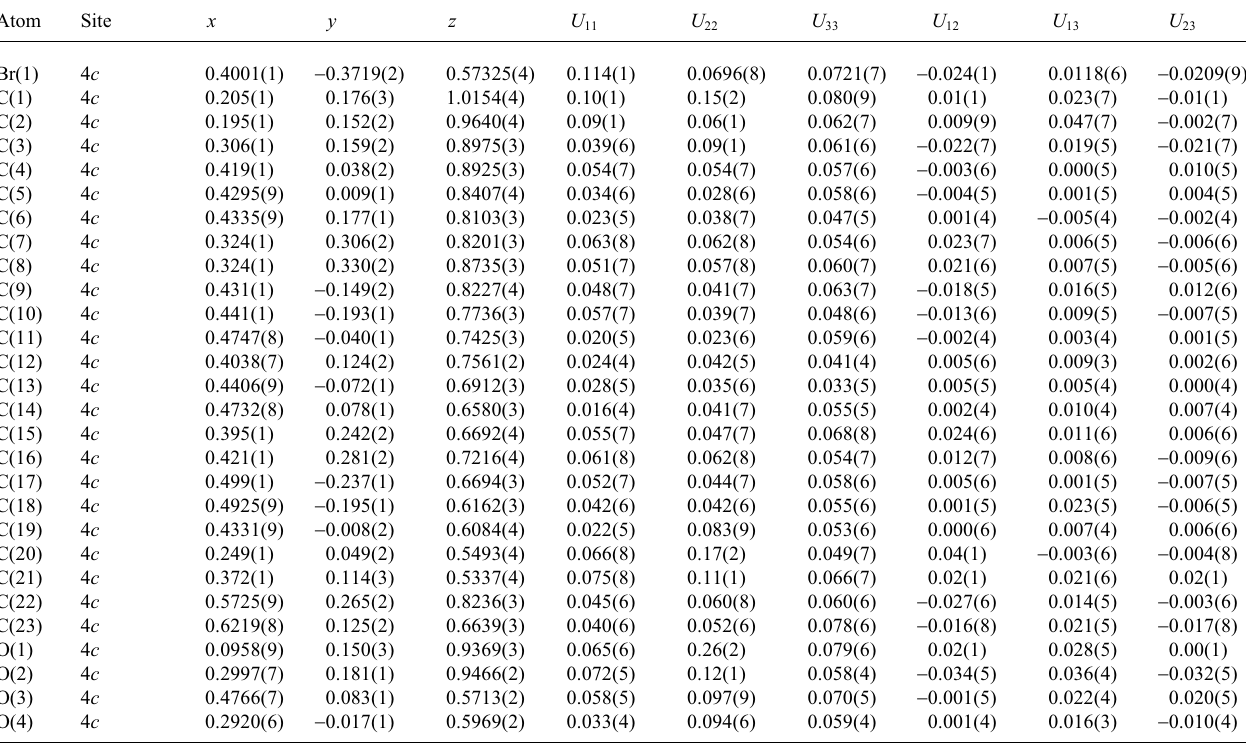
Table 3. Atomic coordinates and displacement parameters (in Å 2 )